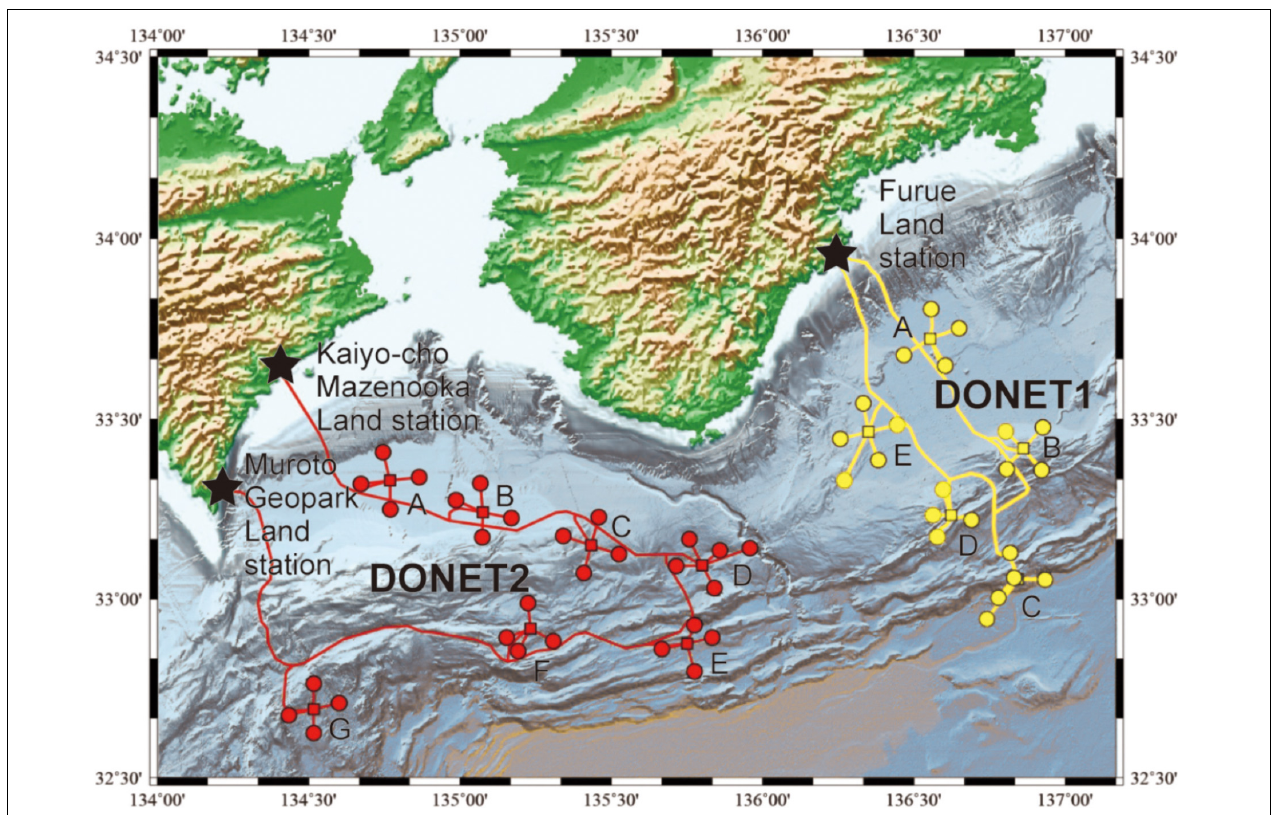
FIGURE 4 | Map of DONET installation. DONET1 and DONET2 observatories are shown with yellow and red circles, respectively. Stars are land stations. Letters indicate nodes (branching apparatuses). Source: Adapted from Takahashi et al.